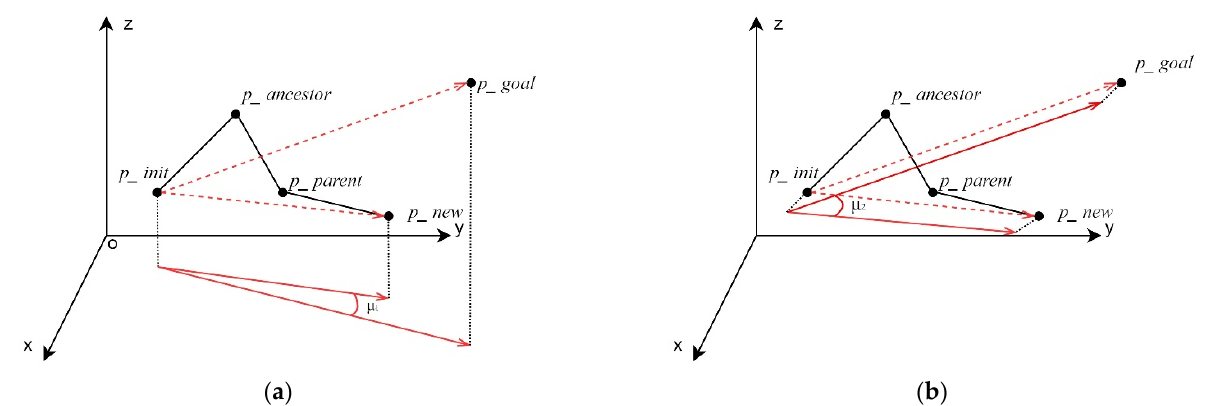
Figure 6. The projection of the angle between the vector ( p _ init , p _ new ) and the vector ( p _ init , p _ goal ) on different planes: ( a ) projection on plane xoy and ( b ) projection on plane